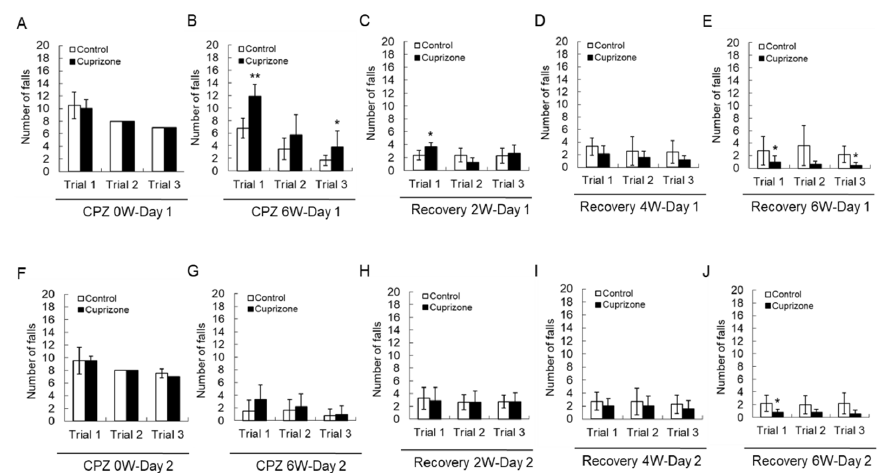
Figure 2. Number of falls in the Rotarod test. ( A – E ) The graphs show the number of falls in three different trials on the first day. ( F – J ) The graphs show the number of falls in three different trials on the second day. Data are expressed as mean ± standard deviation (SD). The final data was made with the results of the total individuals minus the number of sacrificed mice. N = 7 for each group, and differences between groups are expressed as * p < 0.05, ** p < 0.01.